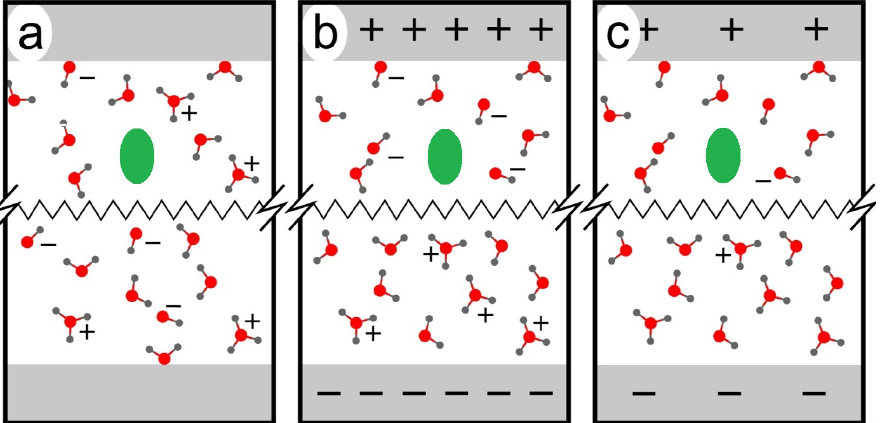
Figure 1. General model: We consider an aqueous solution containing a pollutant (green). ( a ) The situation before applying a potential is stable. The solution contains a small amount of OH − and H 3 O + molecules (in a much smaller concentration than shown here). ( b ) If a potential is applied there is a mass transport of the OH − ions to the anode and of the H 3 O + ions to the cathode. The same accounts for other charged species which may be formed during the reaction. ( c ) Close to the electrode surfaces, the ions are discharged. Due to electronic tunneling, a direct contact to the electrode is not necessarily needed. As a result, we have a pollutant in contact with radicals and with water. We take this as the starting point of our